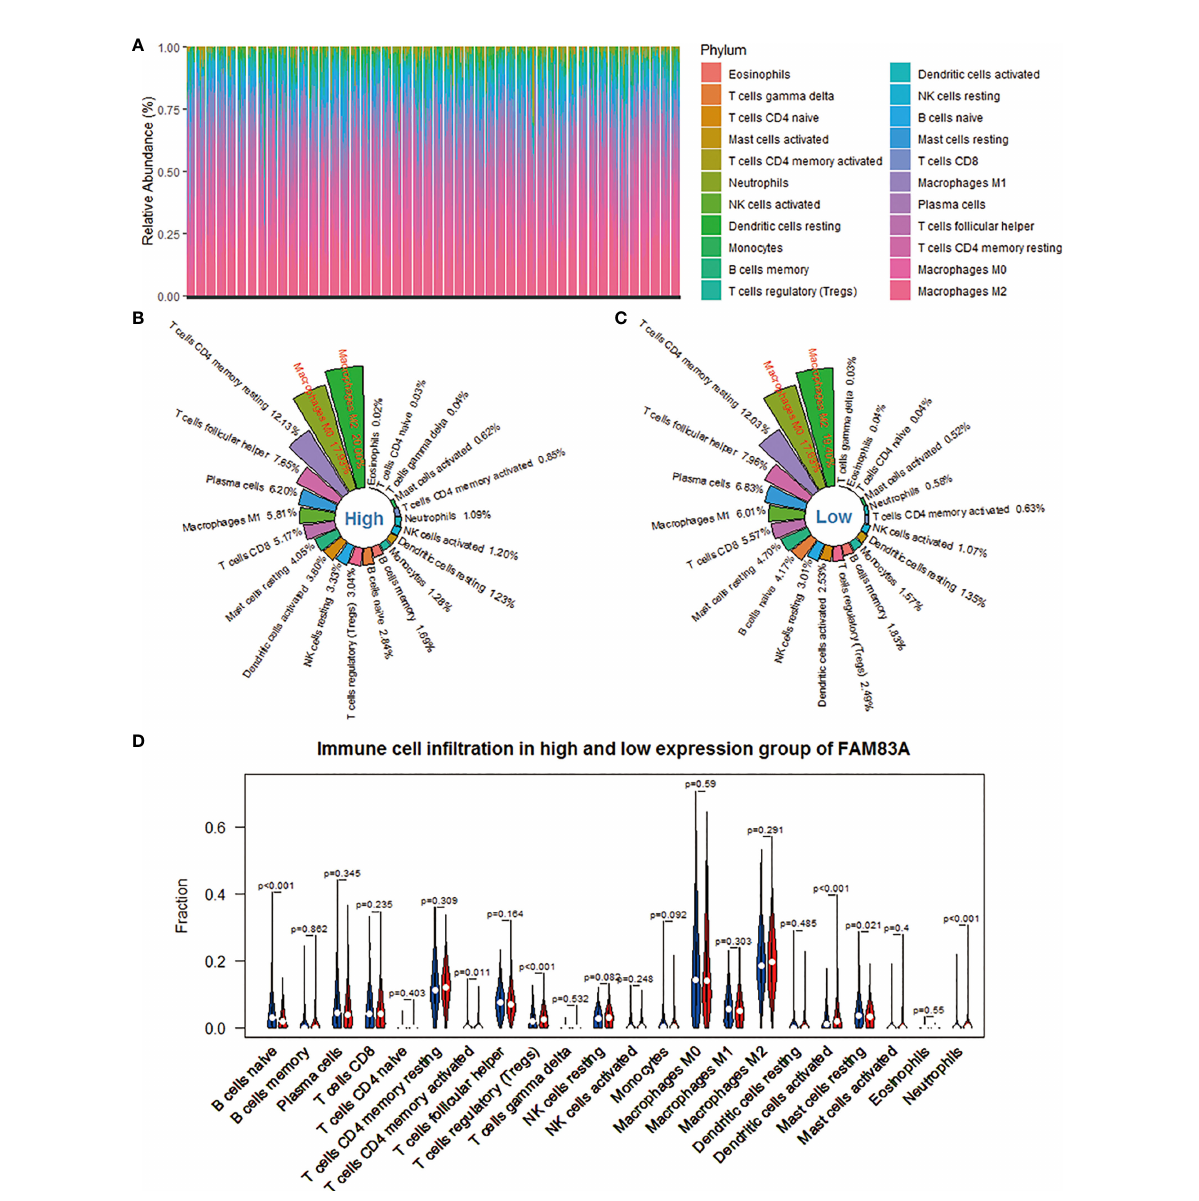
FIGURE 3 Evaluation of the in fi ltration level of 22 immune cells in the NSCLC microenvironment based on the CIBERSORT algorithm. (A) The percentage abundance of 22 kinds of immune cells in NSCLC samples. (B) The distribution of 22 immune cells in the FAM83A high expression group. (C) The distribution of 22 immune cells in the FAM83A low expression group. (D) Differences in immune in fi ltration between FAM83A high and low expression groups. Red represents the high expression group, and blue represents the low expression